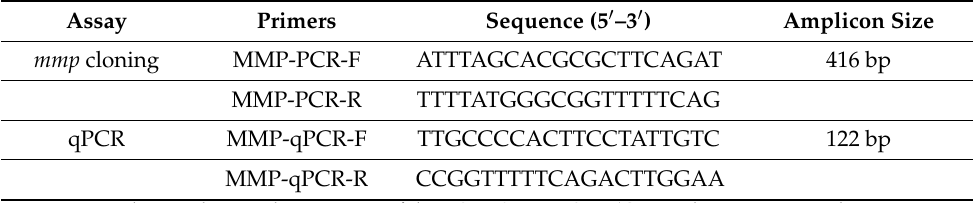
Table A1. Primers designed for viral DNA quantification by real-time